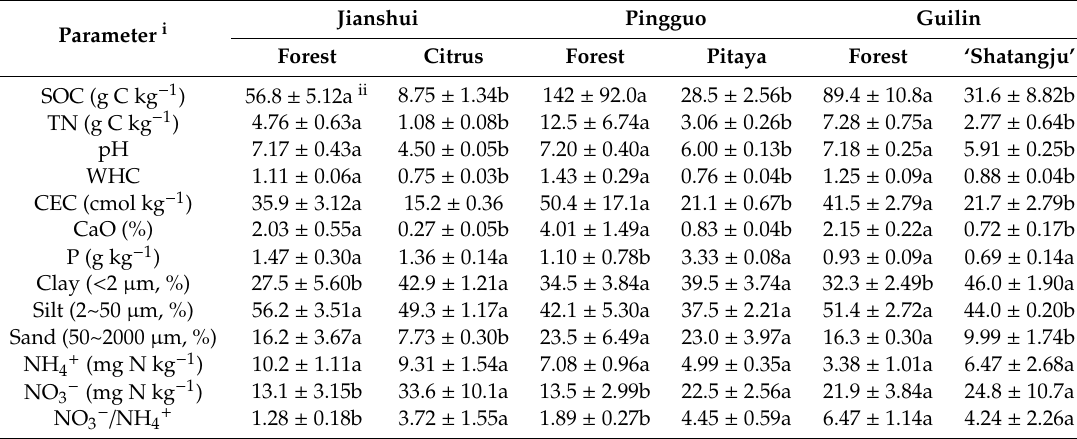
i SOC, soil organic C; TN, total N; WHC, water holding capacity; CEC, cation exchange capacity. ii Identical letters indicate no significant di ff erences in the average values in soils from forest and fruit crop plantation in the same region at p =